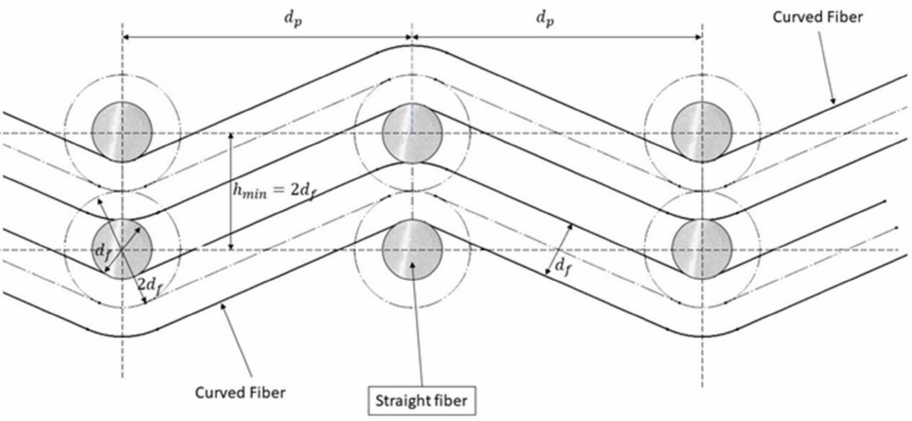
Figure 8. Description of parameters for closely packed wire-mesh layers in stacking of inline type-a.